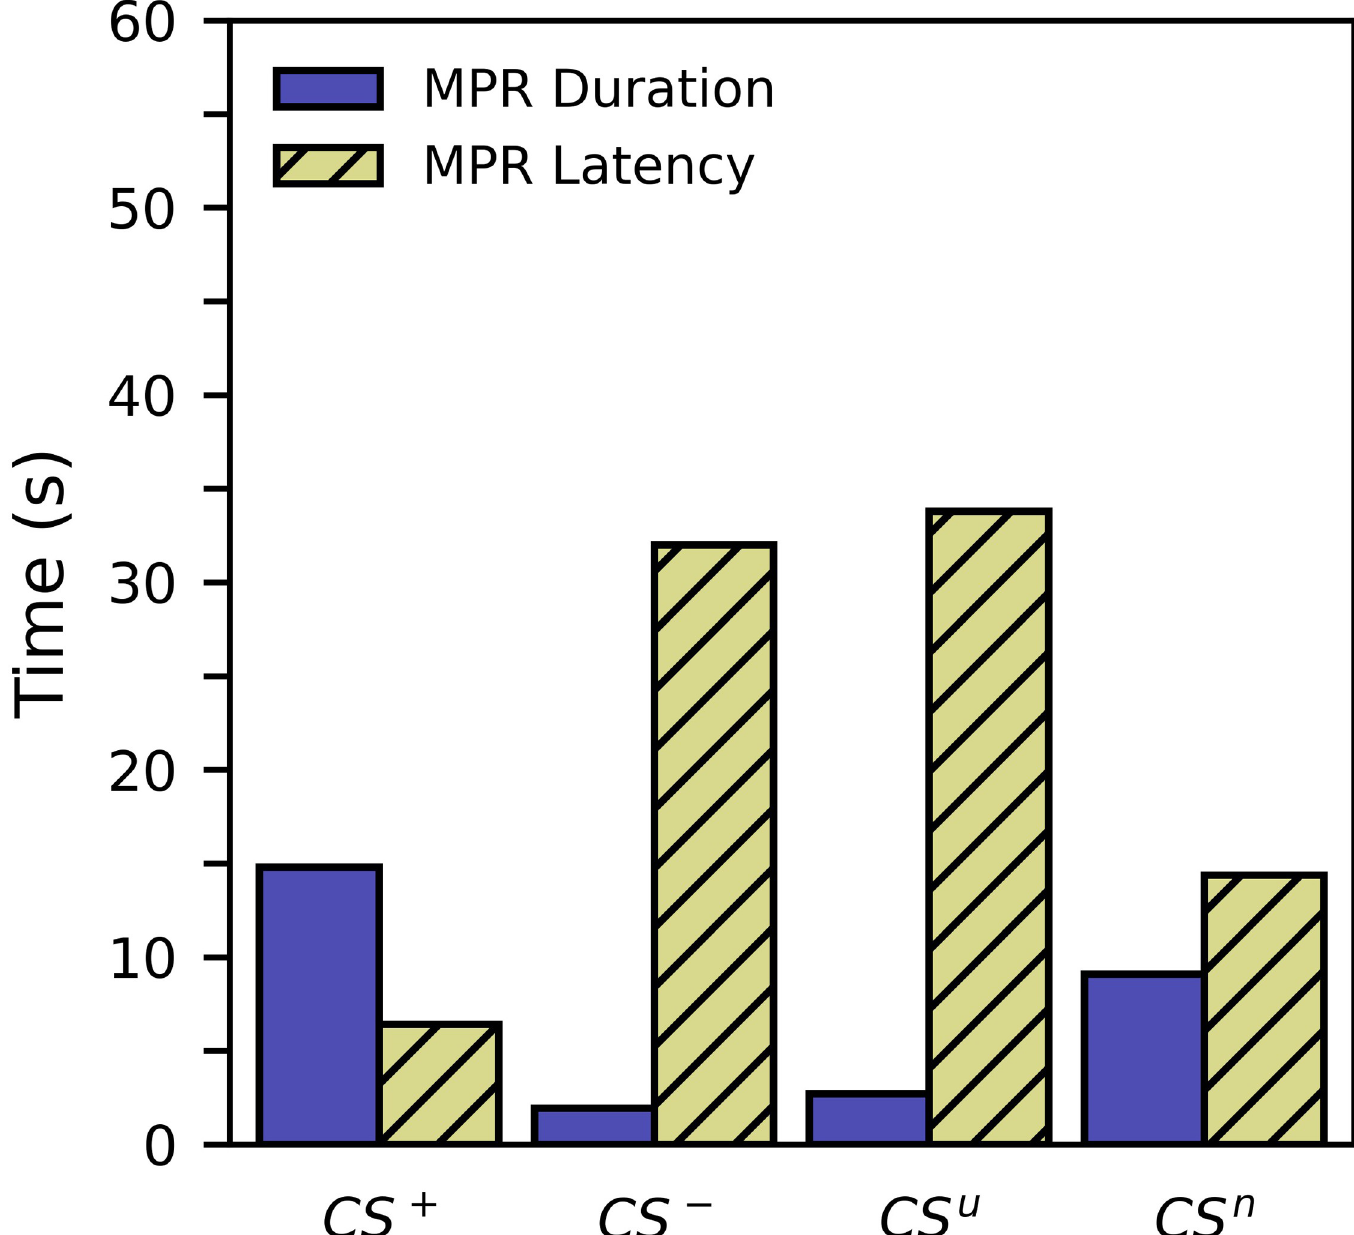
Fig 4. Experiment 1 average MPR duration and latency for the paired and unpaired groups during the preference test. The number of subjects responding to the CS + , CS - , CS u and CS n were 25, 10, 13, and 20, respectively. Averaged latency values exclude non-responders. https://doi.org/10.1371/journal.pone.0272598.g004 Table 8 shows analysis for the probability of responding to the CS + or CS - . For the appeti- tive CS + , the response probability was initially significantly greater than chance (50%; p = 0.000), and decreased slightly, but significantly, as a function of time ( p = 0.001). Respond- ing to the aversive CS- was significantly less than chance ( p = 0.018), and also decreased as a function of time, but this effect was only borderline significant ( p = 0.049). Pairwise compari- sons suggest that the decrease with time was statistically similar for both stimuli ( p = 0.527).